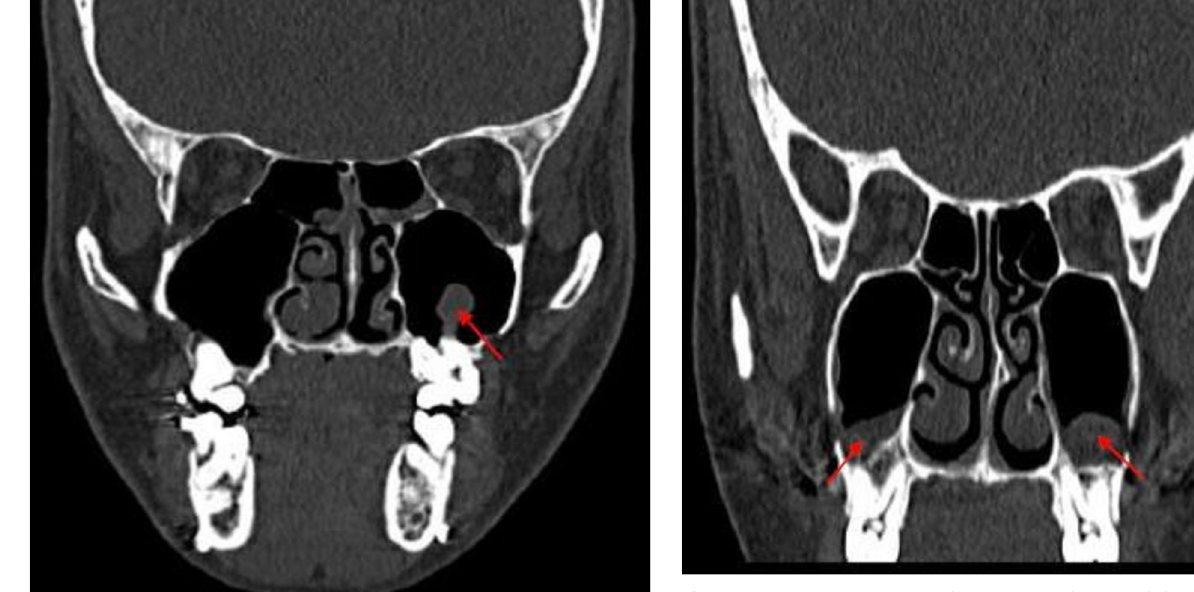
Fig. 7. Postoperative coronal CT image showing bilateral mucosal thickening in the base of the maxillary sinus (arrows).